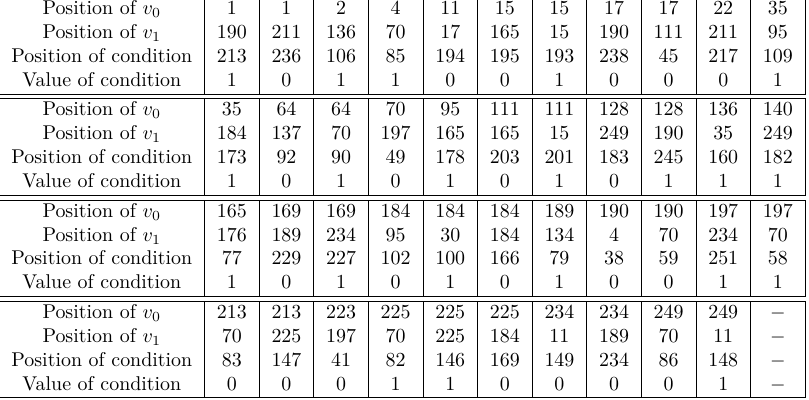
Table 9: Parameters for TYPE-IV conditional cube